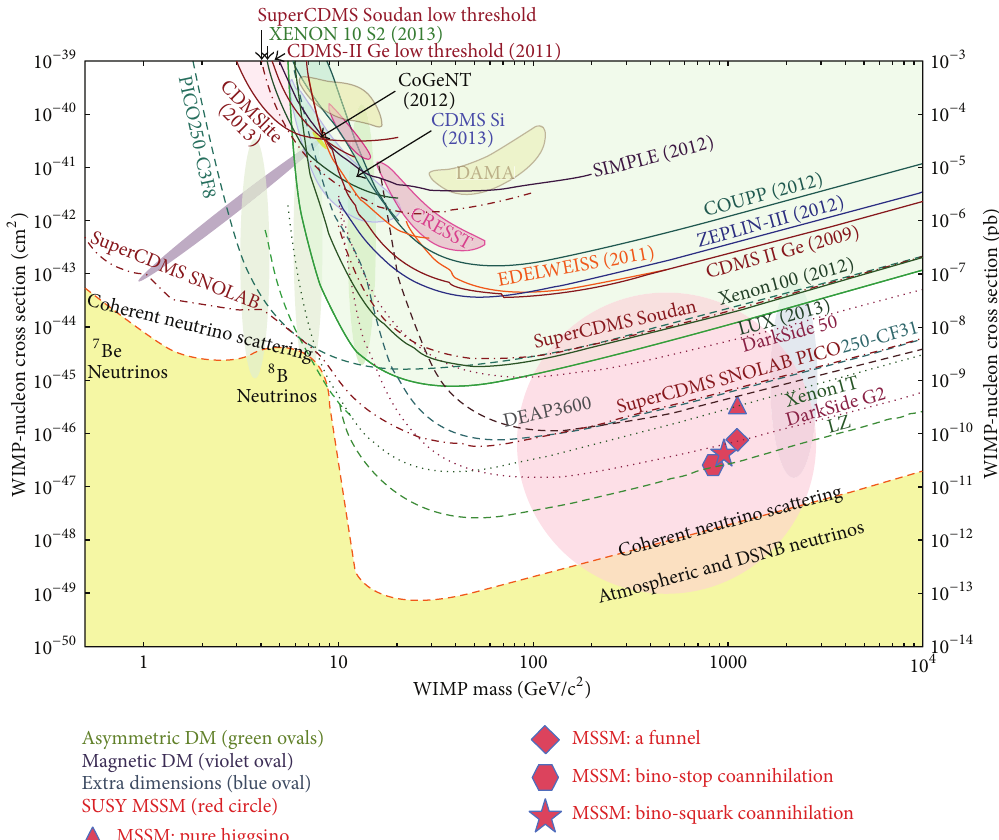
Figure 4: Current status of direct dark matter searches results and sensitivity of future experiments (from [24]). Shaded bounded areas represent claims for dark matter observations or regions of interest compatible with observation of a few events that could be attributed to dark matter interactions. Continuous lines show the exclusion curves by past experiments. Dashed lines show the projected sensitivity of future experiments based on various assumptions. The red dashed line shows the sensitivity of DarkSide-G2 for zero detected events in 18